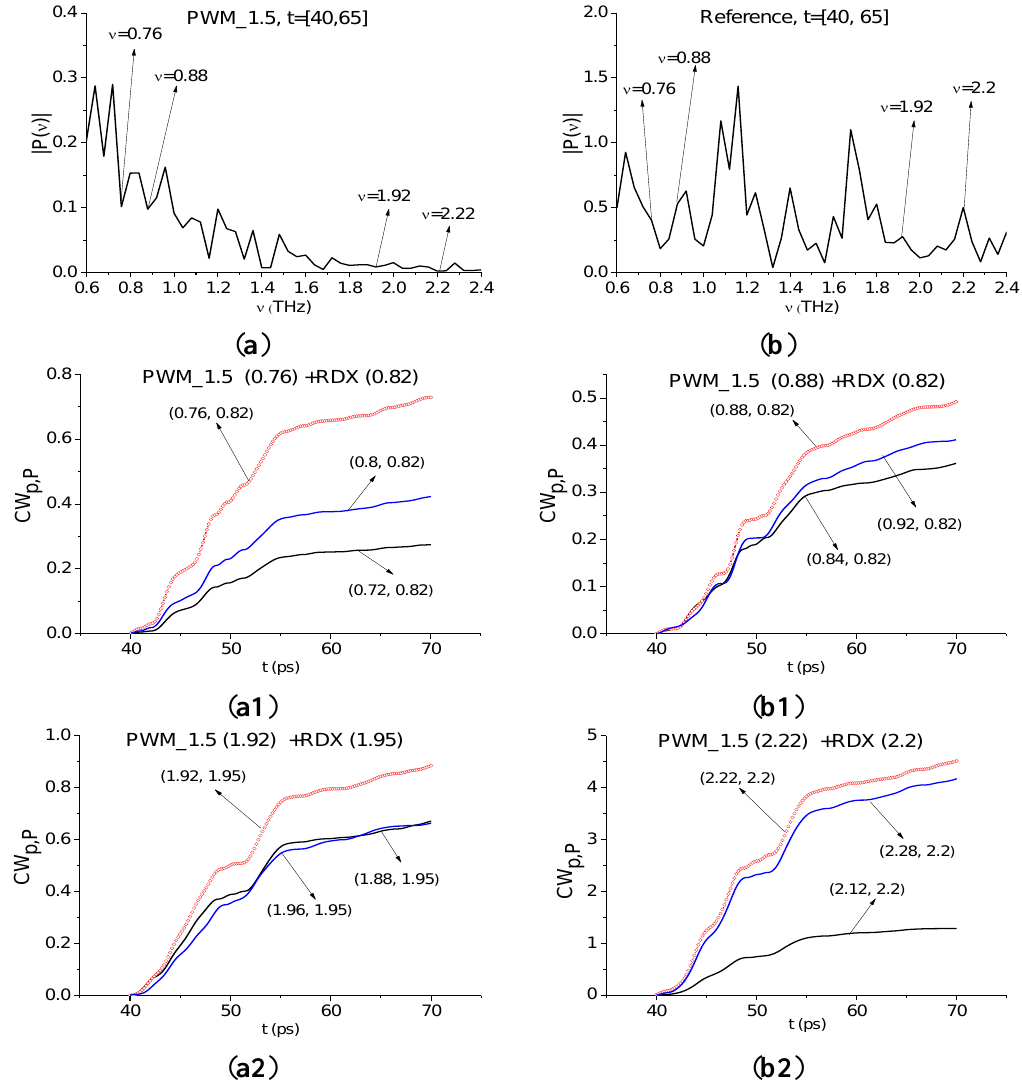
Figure 23. Fourier spectrum of the first sub-pulse of the PWM_1.5 signal ( a ) and Reference signal spectrum ( b ) in the frequency range ν = [0.6, 2.4] THz; integral characteristics CW p , P ( t n ) detecting the frequencies ν = 0.76 THz ( a1 ); 0.88 THz ( b1 ); 0.92 THz ( a2 ); 2.22 THz ( b2 ).